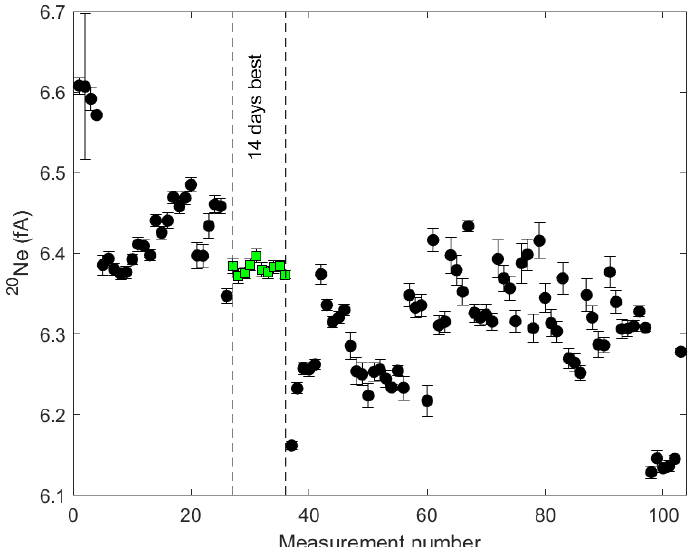
Figure 5. 20 Ne intensities from the repeated analysis of 3.2 × 10 − 11 cm 3 STP 20 Ne of air using the ARGUS VI mass spectrometer. Repeatability over the 4 months analytical period was 1.13% (ignoring 9 outliers out of 103). The best 14-day period (green squares) (n = 10) exhibited a repeatability of 0.16% when no interruption of sample analysis occurred. The 21 Ne concentration of air/calibration aliquot was equivalent to that of 7.7 mg CREU-1 quartz. Long-term variability seems to be the natural variability of sensitivity, which we think is the best representation of the repeatability of unknowns.